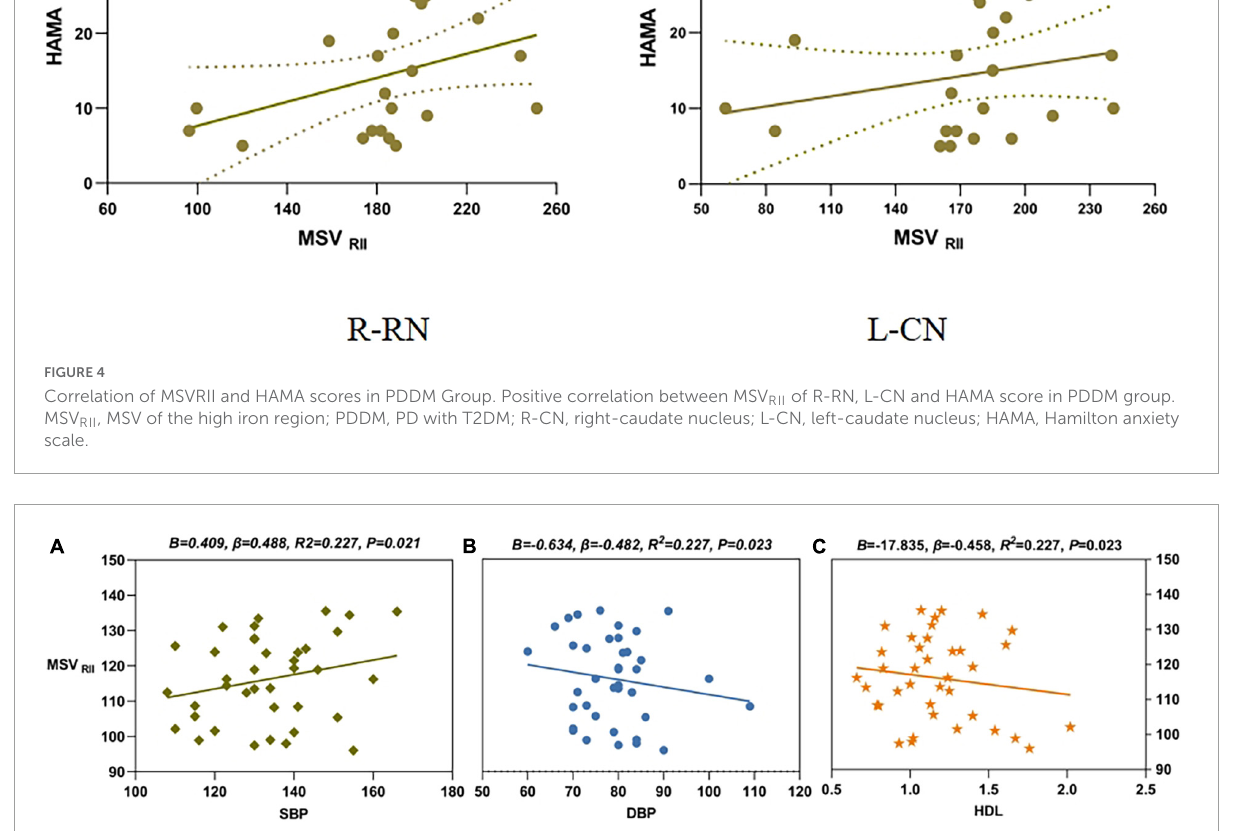
FIGURE5 The results of multiple linear regression. (A) SBP level ( B = 0.409, β = 0.488, R 2 = 0.227, P = 0.021) was positively correlated with MSV RII of R-CN in PDDM group. (B) DBP level ( B = -0.634, β = -0.482, R 2 = 0.227, P = 0.023) was negatively correlated with MSV RII of R-CN in PDDM group. (C) HDL level ( B = -17.835, β = -0.458, R 2 = 0.227, P = 0.023) was negatively correlated with MSV RII of R-CN in PDDM patients. MSV RII , MSV of the high iron region; PDDM, PD with T2DM; R-CN, right caudate nucleus; SBP, systolic pressure; DBP, diastolic pressure; HDL, high-density